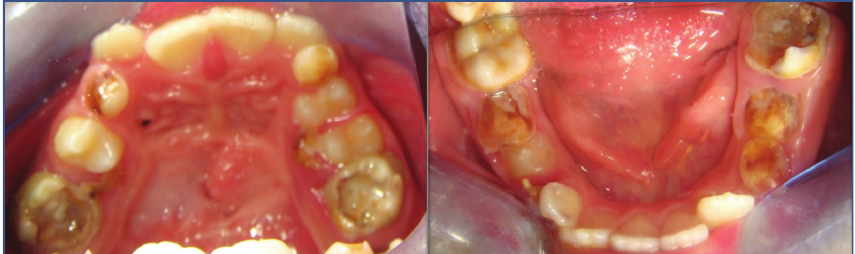
Figure 4: In intraoral findings, numerous carious teeth (#16, #55, #53, #26, #65, #63, #36, #75, #74, #46, #85, #84, and #83), hypomineralisation (#16, #26, #36, and #46), and cleft palate were seen.